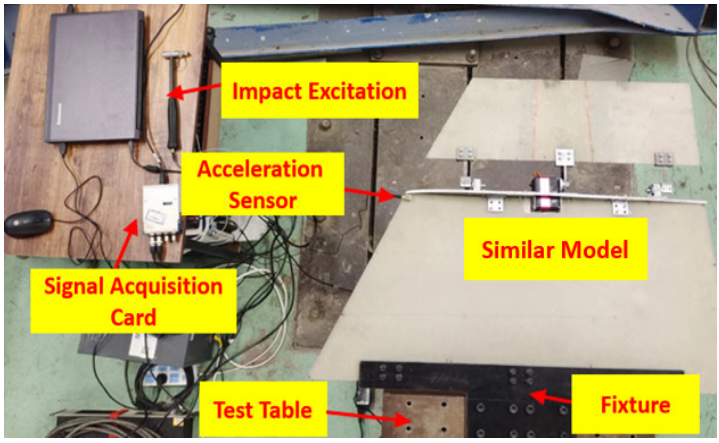
Figure 3. Experimental model ground modal knockout experiment.